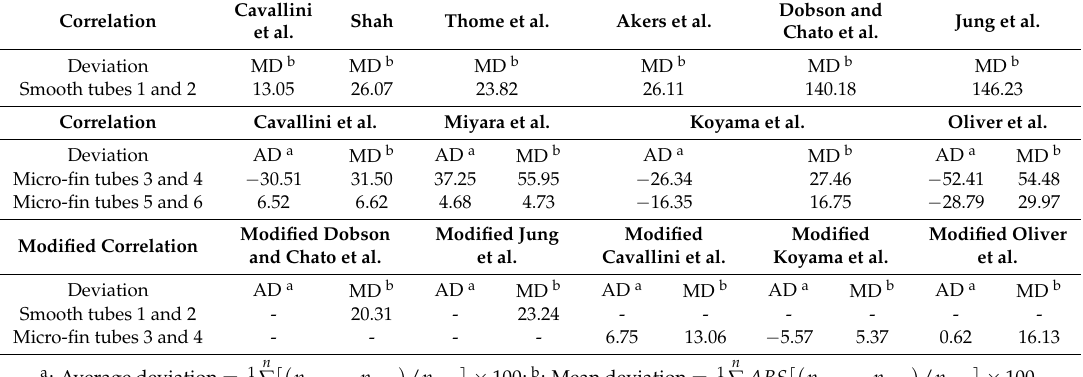
( i ) Figure 12. Comparison of prediction methods with experimental data for micro-fin tubes: Cavallini et al. for micro-fin tubes ( a ) 3 and 4; and ( b ) 5 and 6; Miyara et al. for micro-fin tubes ( c ) 3 and 4; and ( d ) 5 and 6; Koyama et al. for micro-fin tubes ( e ) 3 and 4; and ( f ) 5 and 6; Oliver et al. for micro-fin tubes ( g ) 3 and 4; and ( h ) 5 and 6; ( i ) instructions of point. For micro-fin tubes 3 and 4, while the Miyara et al. correlation overestimates the heat transfer coefficient, correlations of Cavallini et al., Koyama et al. and Oliver et al. underestimate the experimental data and their predictive errors increase with the increase of mass velocity. The Miyara et al. correlation was proposed based on the experiment data in a herringbone-type micro-fin tube. Although condensate film inside the tube is invisible, one thing is for sure: the enhancement